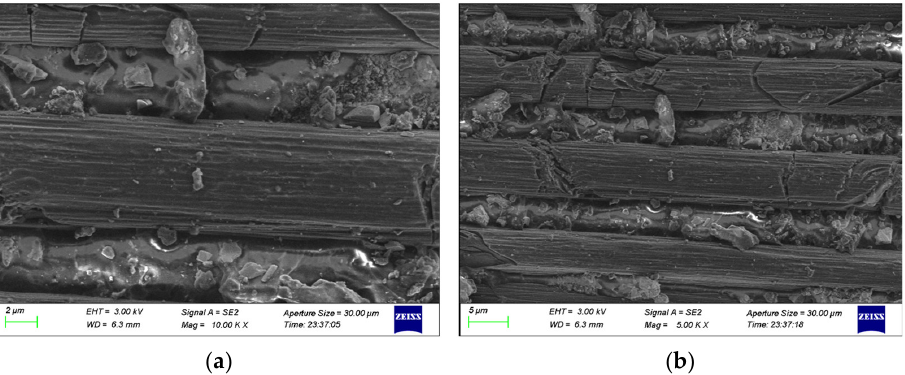
Figure 10. Surface morphology of CF/EP single-lap joints with sandblasting and plasma treatment for 125 s at ( a )10 k times magnification and ( b ) 5 k times magnification. for 125 s at ( a )10 k times magnification and ( b ) 5 k times magnification.